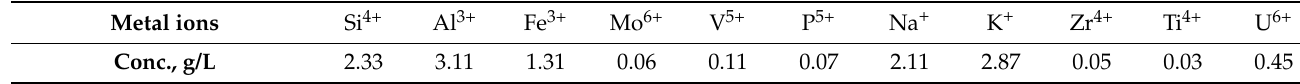
Table 7. The chemical analysis of G. Gattar granite leach liquor.